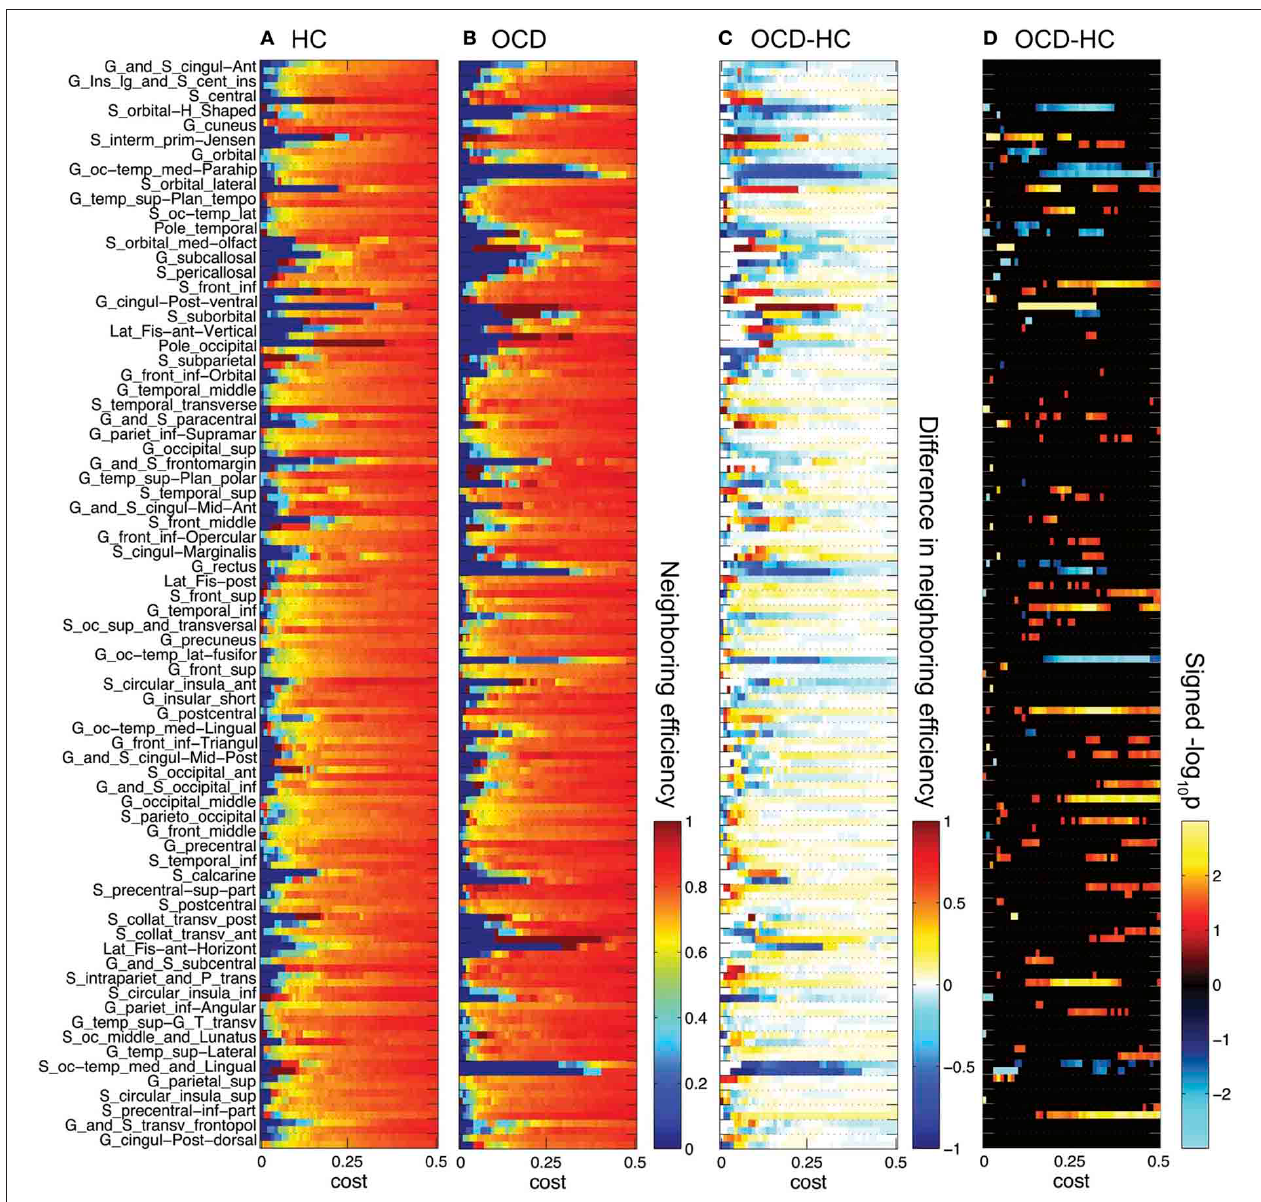
FIGURE 4 | Neighboring efficiencies for 148 ROIs are plotted over cost for the controls (HC, A) and the OCD patients (OCD, B). The group differences as HC subtracted from OCD (C) and the signed logarithmic